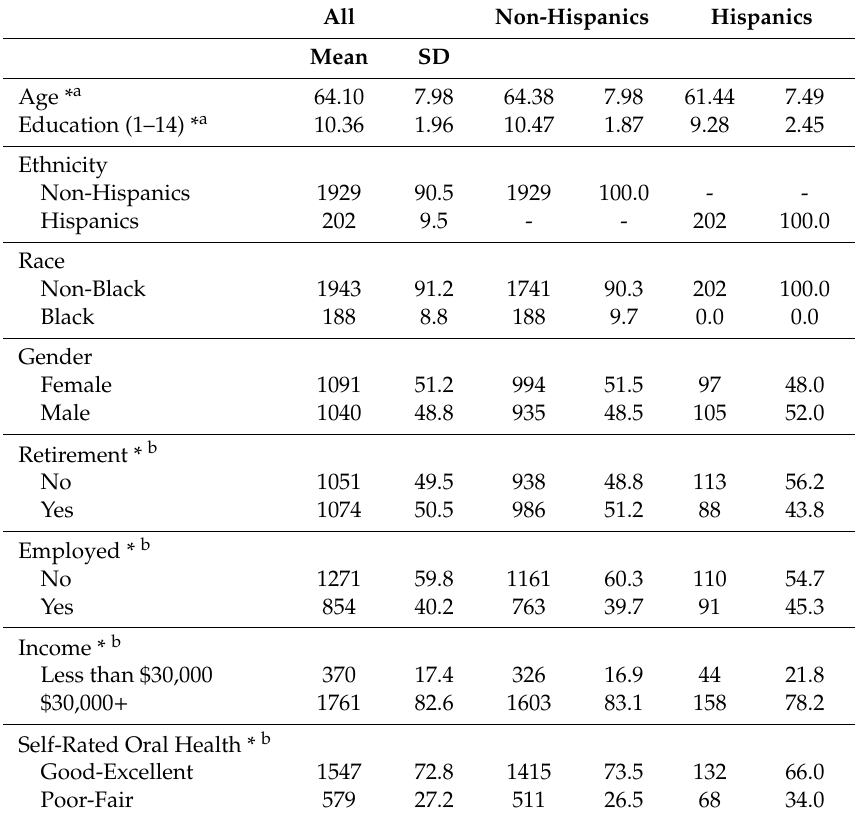
Table 1. Descriptive data of the pooled sample and in ethnic groups.